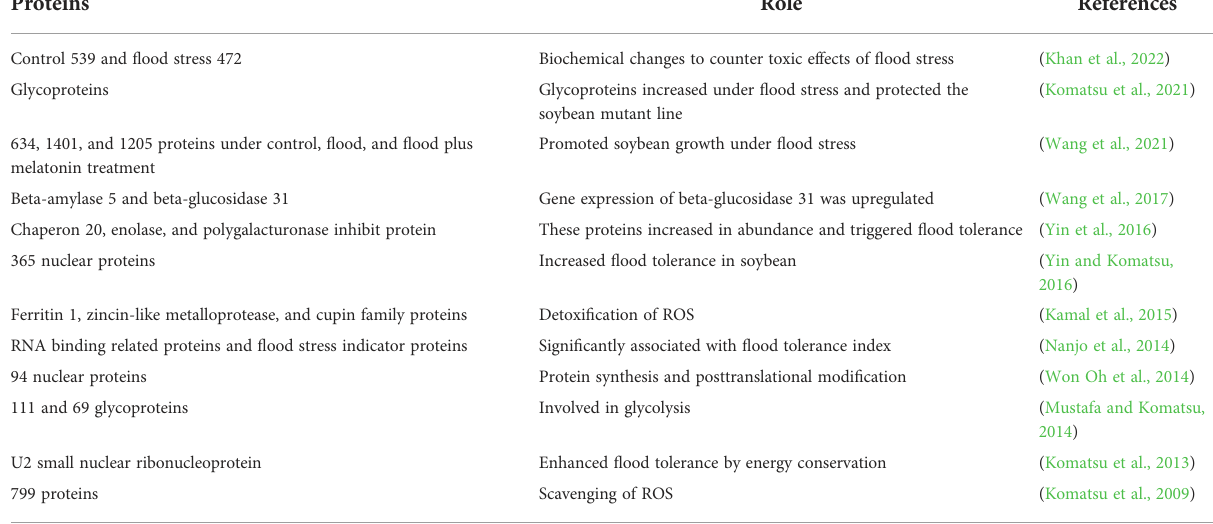
TABLE 4 Identi fi ed proteins for soybean response to fl ood stress.